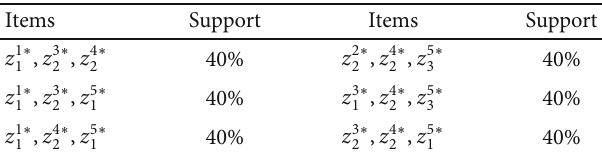
Table 10: Frequent item set L